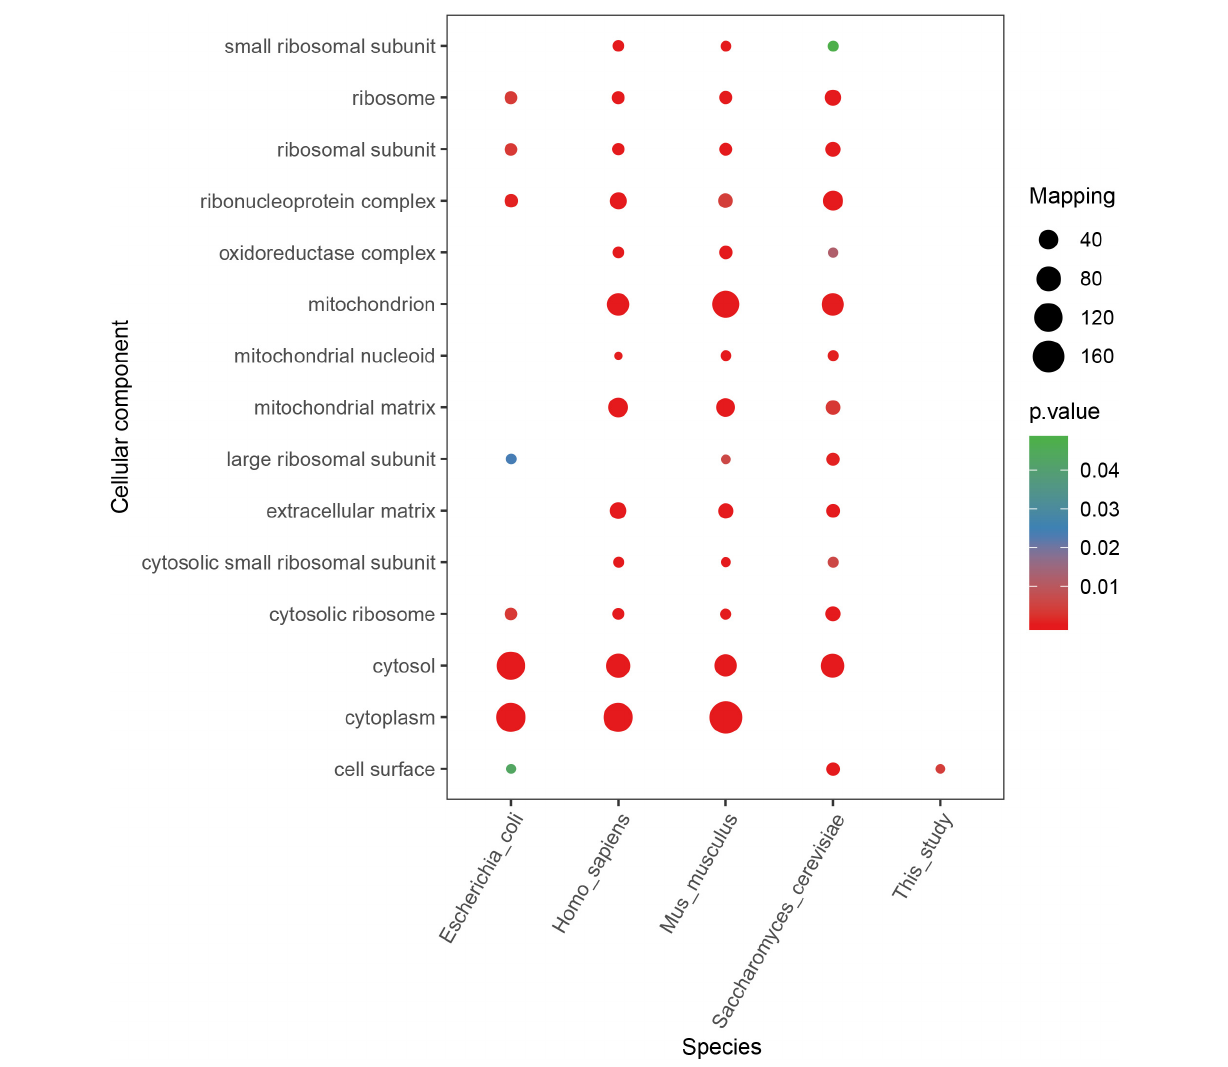
epidermidis ), which is consistent with the laws of